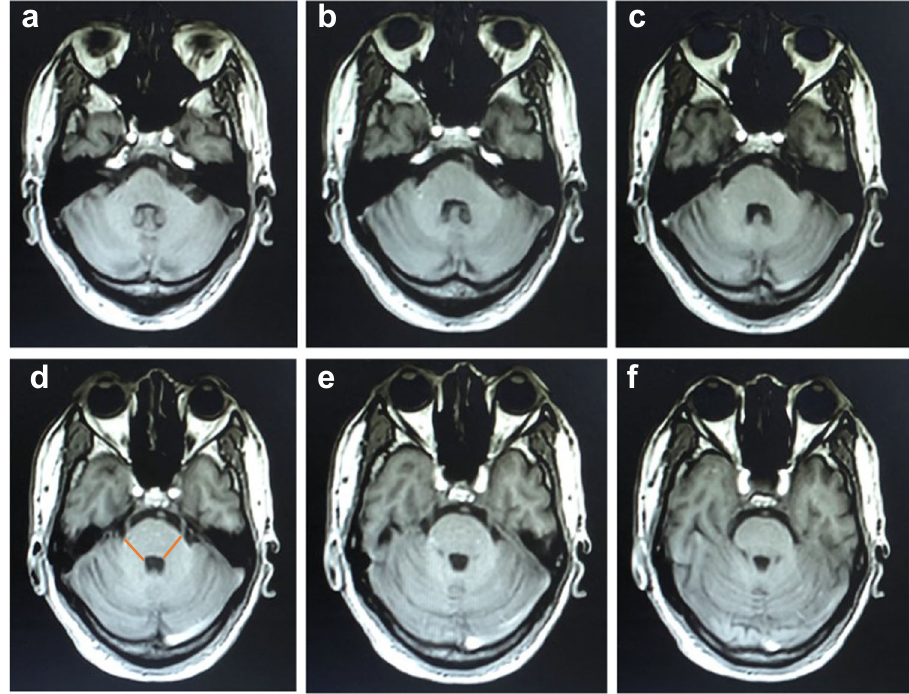
Fig. 4 Representative three ‐ dimensional T1 ‐ weighted axial images of pons and MCPs. a – f represented an axial view from the pontomedullary junction to the level of the pontine midbrain junction. Slice thickness was 2 mm, and the maximum width of MCP was shown on image d . The MCP value was determined by the averaged values on the widths of both MCP sides. MCP middle cerebellar